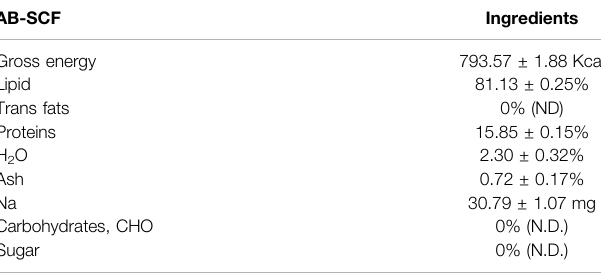
TABLE 4 | Nutrition facts in AB-SCF (per 100 g). AB-SCF